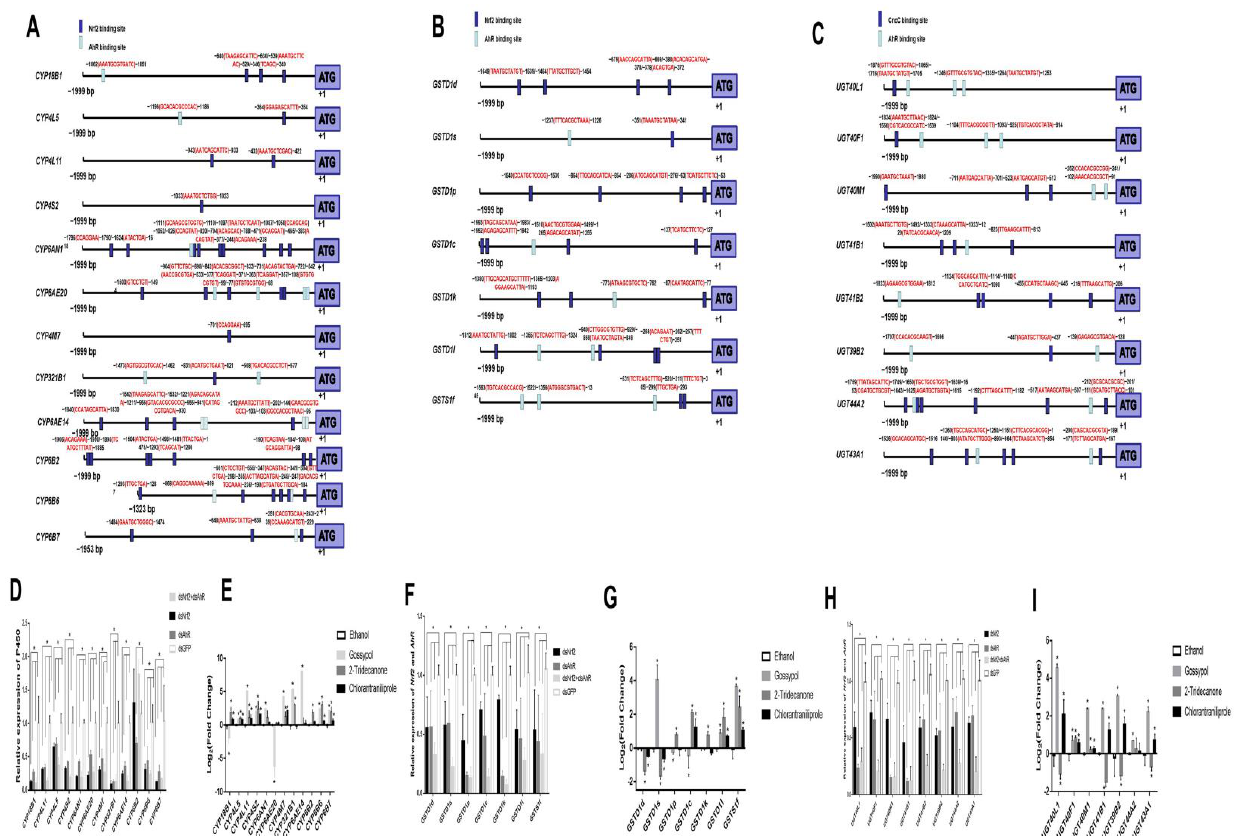
Figure 3. Transcription factor binding sites prediction ( A − C ) and RT-qPCR validation ( D − I ) of down-regulated P450, GST and UGT genes associated with HaNrf2 and HaAhR knockdown and xenobiotics (gossypol, 2-tridecanone and chlorantraniliprole) treatment. Analysis of the P450, GST and UGT genes’ promoter regions were performed to identify possible regulatory elements. An- tioxidant response element (ARE) for Nrf2 (ARE/Nrf2: TMANNRTGAYNNNGCRWWW; DMAT- GCTKWGT; WCAGHAW), and xenobiotic response element (XRE) from the aryl hydrocarbon receptor (XRE/AhR: TNGCGTG; NCACGCNNN; GAKKTGCGTGASAAGAG; MRGSYTCTTCT- CACGCAACTCC; KYKKCTCACGCWRYW; DCACGCAASKCHSAAW; CACGTGCAA). Element position “+1” is defined relative to the start codon ATG. Asterisks on error bars show significant differences ( p <